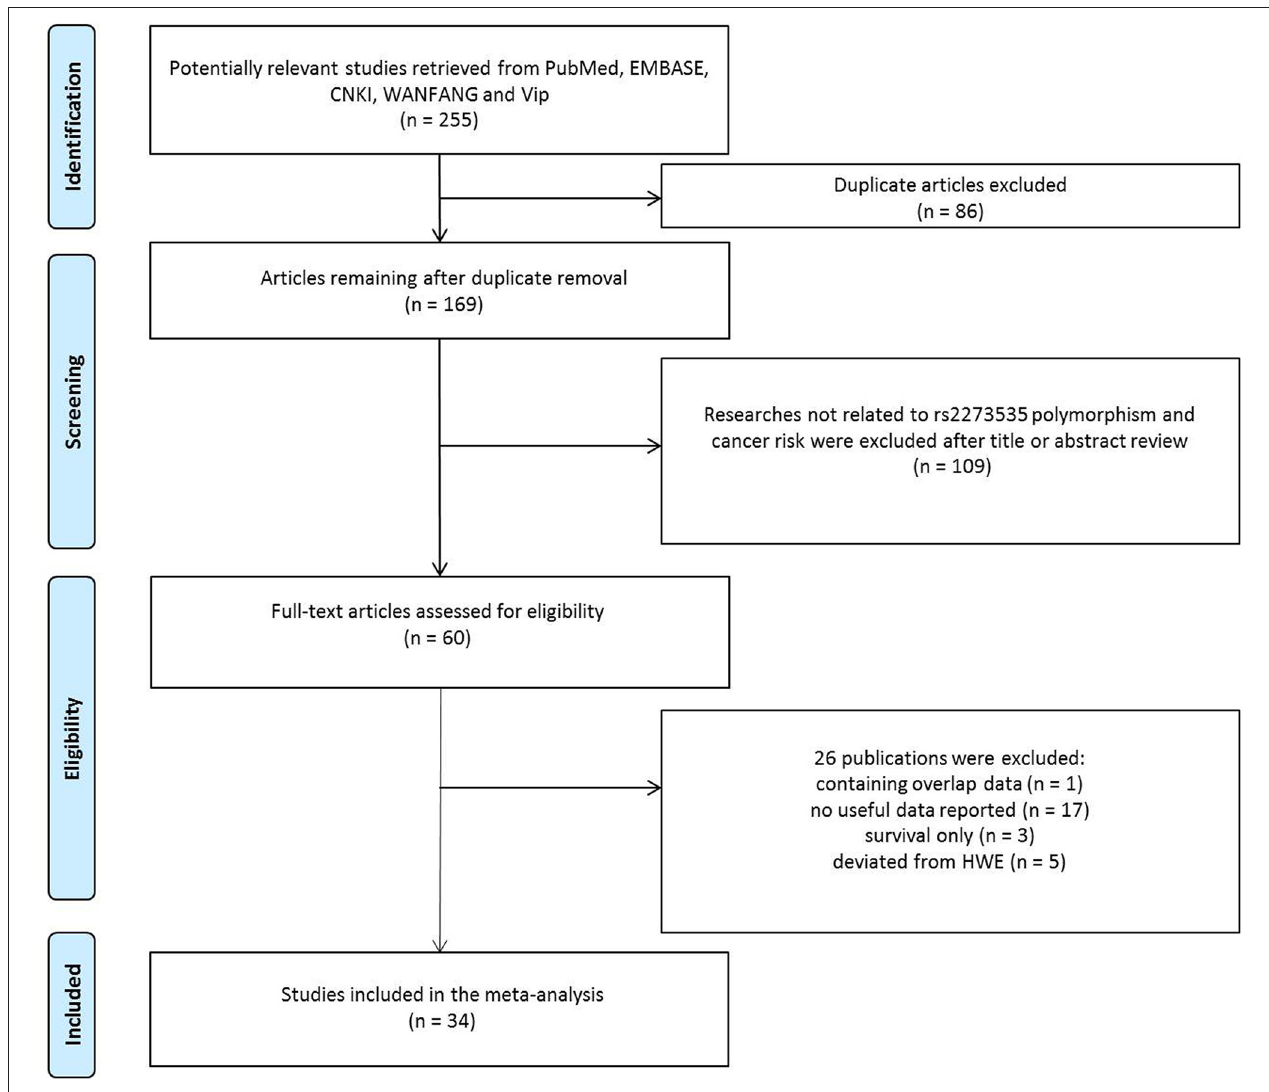
FIGURE 1 | Flowchart of included